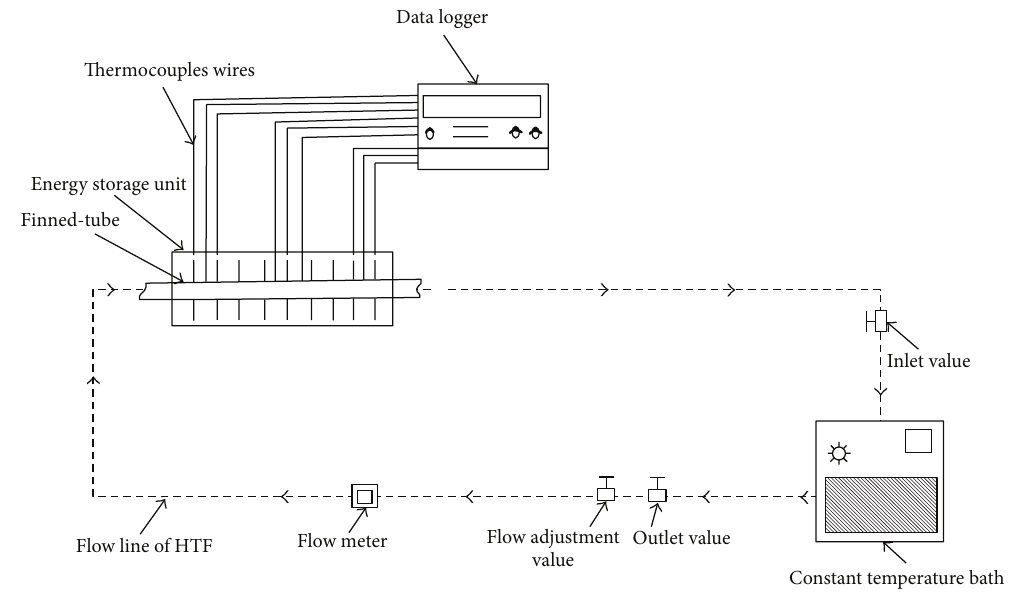
Figure 1: Schematic view of the experimental setup.